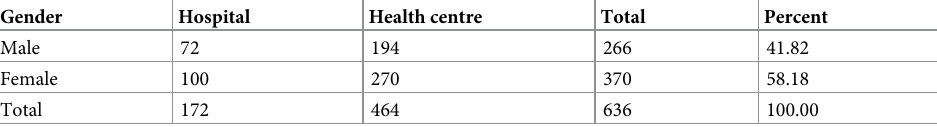
Table 1. Respondents’ gender and distribution at the study healthcare facilities, Addis Ababa City Administra- tion, February 2018.